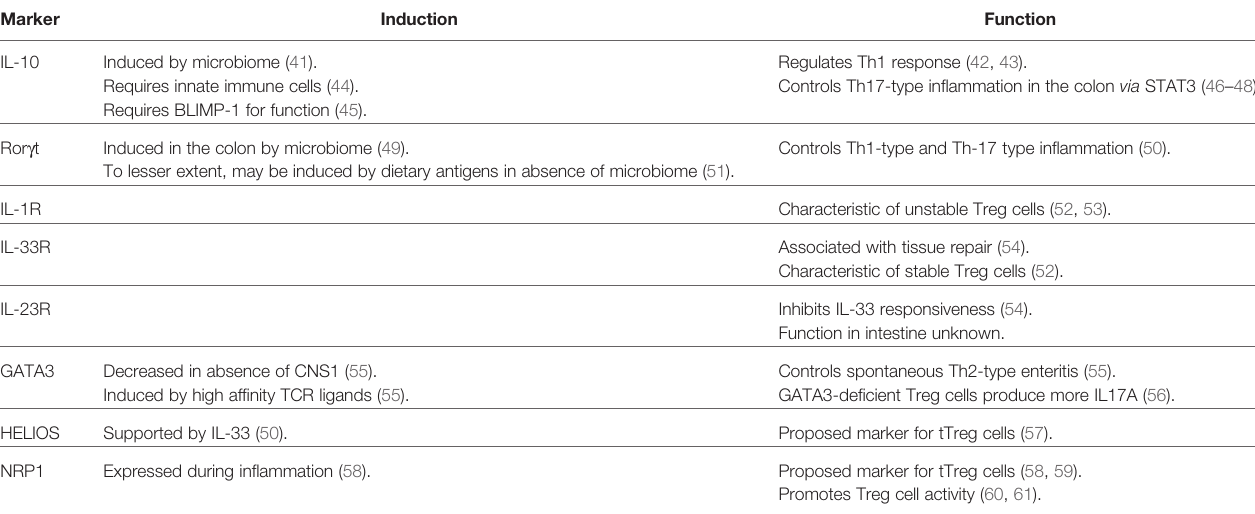
TABLE 1 | Markers of intestinal Treg cells and the gist of their phenotype translated to intestinal immune homeostasis. Marker Induction Function IL-10 Induced by microbiome (41). Regulates Th1 response (42, 43). Requires innate immune cells (44). Requires BLIMP-1 for function (45). Induced in the colon by microbiome